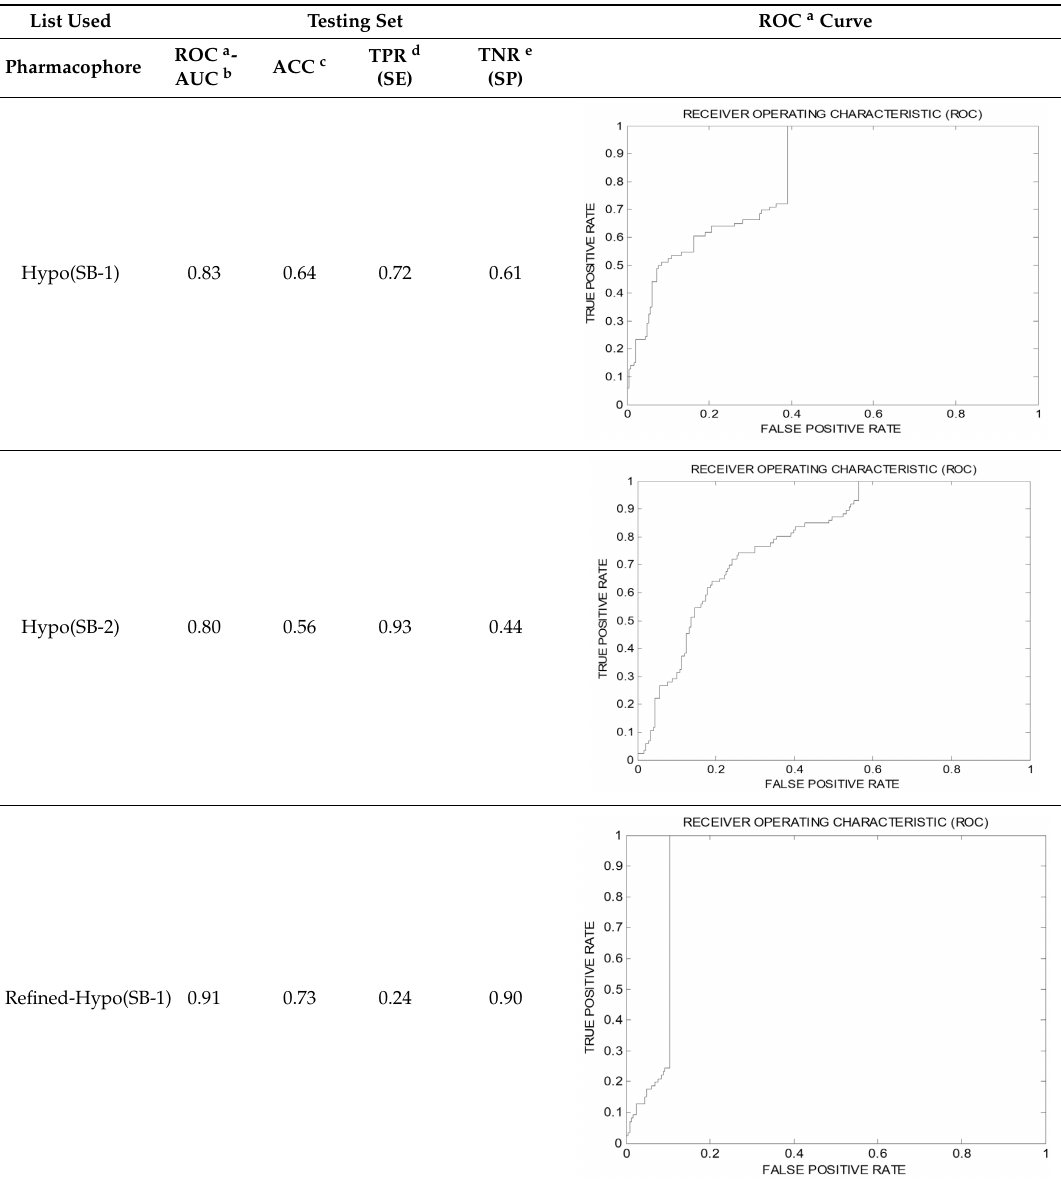
Table 4. ROC performances of dbCICA pharmacophores and the refined Hypo(SB-1) pharmacophore model using Testing Set